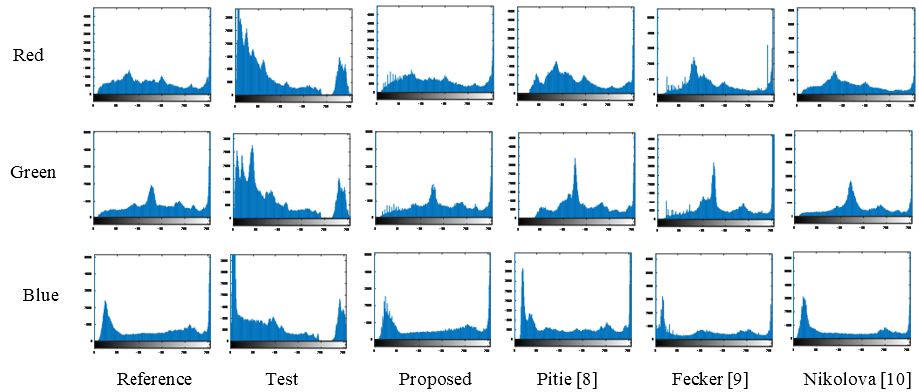
Figure 8. Histogram comparisons for overlapping regions in Figure 7. The first column shows the histograms of overlapping regions in the reference image, the second column shows the corresponding histograms in the test image, the third column shows the corresponding histograms of overlapping regions after the proposed method, the fourth column shows Pitie’s result, the fifth column shows Fecker’s result, and the last column shows Nikolova’s